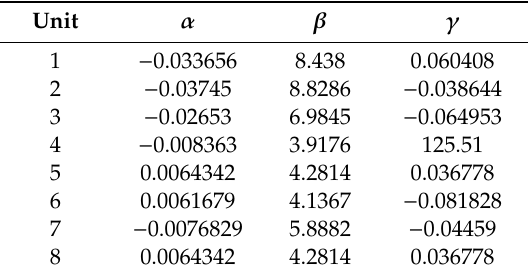
Table A2. NO X emission coe ffi cients.